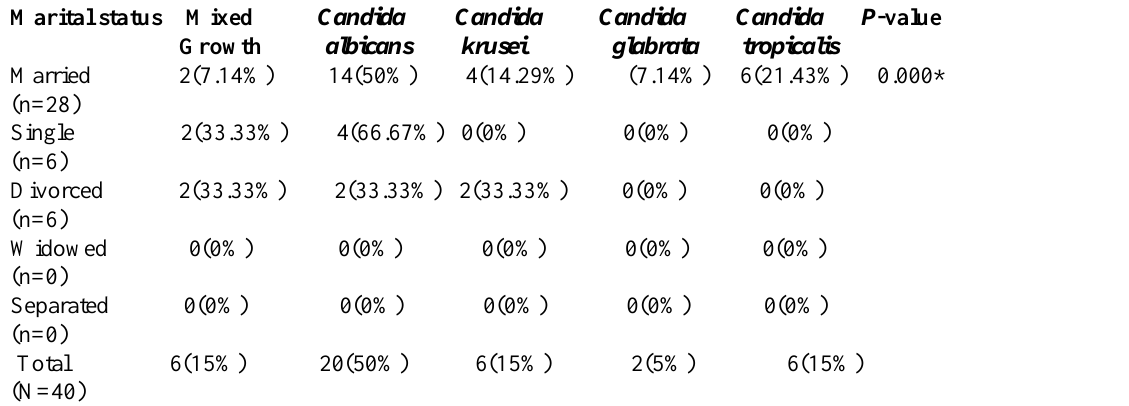
Table 7. Candida isolates based on marital status of the